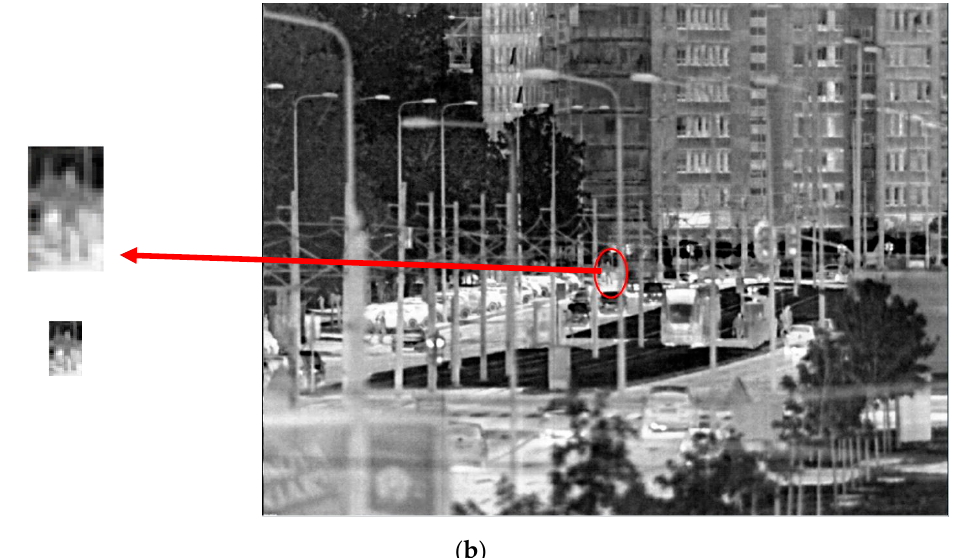
Figure 10. Images taken by SYS3 that represent human identification at a calculated range: ( a ) 800 m; ( b ) 1100 m.